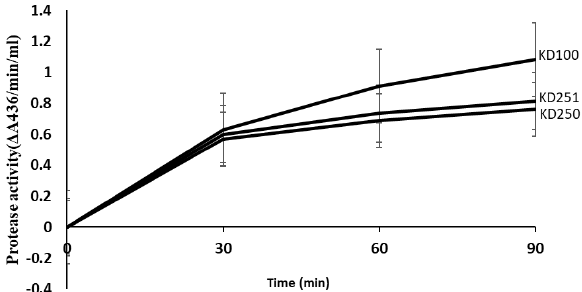
Figure 3. Quantitative assays for enzymatic activities of extracellular protease from P. carotvorum strain KD100 and its wcaG - mutants KD250 and KD251. The parental strain, KD100 and wcaG mutants KD250, KD251 were cultured (three replicates were taken from culture tube of each strain) in MM